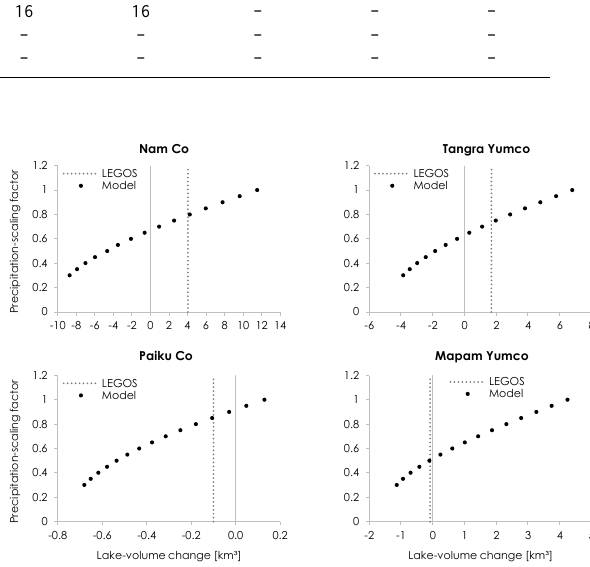
Figure 2. Model-simulated lake-volume changes for Nam Co, Tan- gra Yumo, Paiku Co and Mapam Yumco for the time periods given in Table 2 using precipitation-scaling factors varying between 0.3 and 1.0. The dotted line indicates lake-volume changes derived from remote-sensing data provided by LEGOS. The point where model dots are closest to the dotted line was taken as the precipitation- scaling factor for each